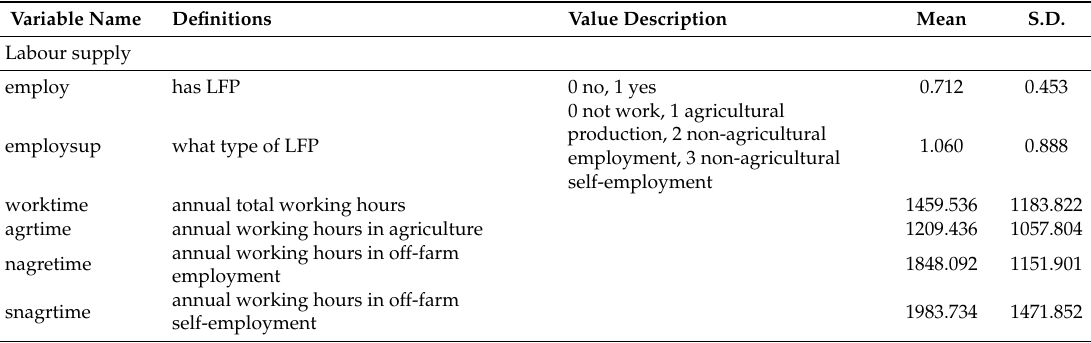
Table 1. Variable definition and value